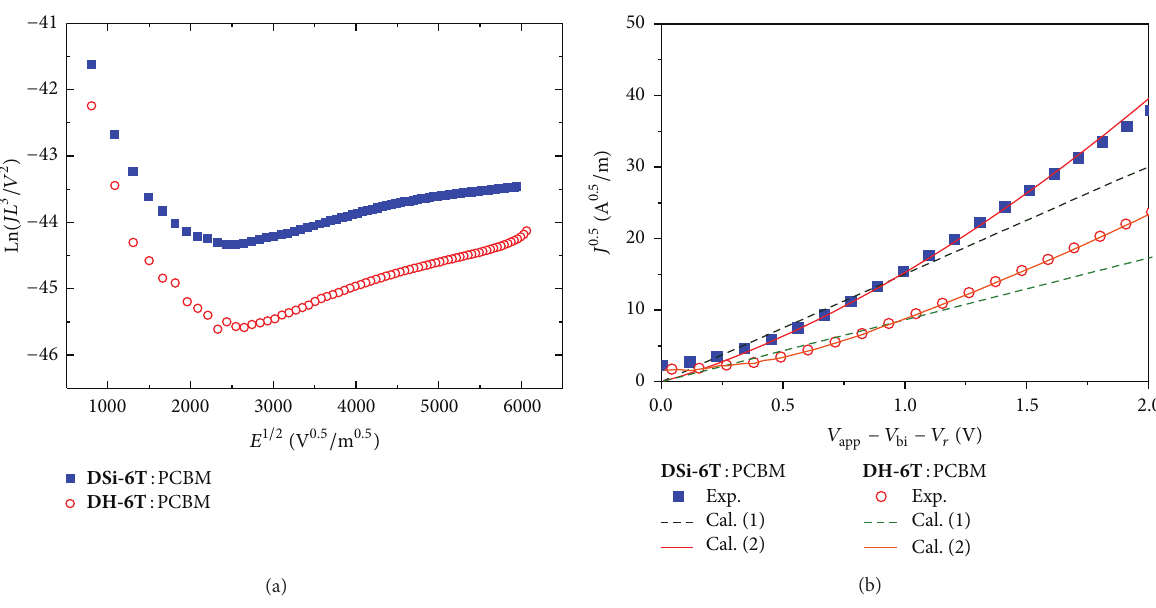
Figure7:(a)ln( 𝐽𝐿 3 /𝑉 2 )versus 𝐸 1/2 curvesaccordingtotheSCLCequation(2).(b) 𝐽 1/2 versus 𝑉 curvesshowingtheelectric-field-dependence of hole mobilities at highly biased region. Dotted and solid lines are calculated curves with (1) and (2),